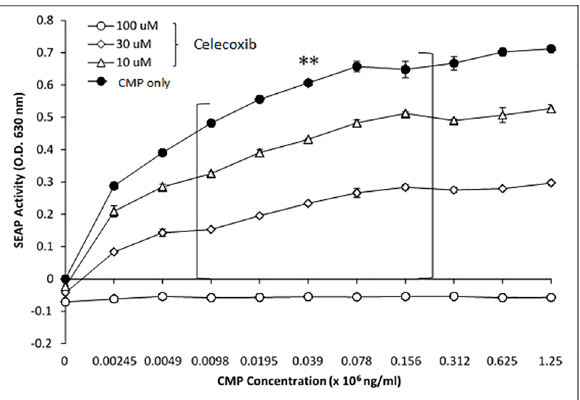
Fig 7. Celecoxib inhibits CMP activation of TLR4 in a dose-dependent manner. HEK-TLR4 cells were pre-treatedwith with 0 μ M (filled circles), 10 μ M (open triangles), 30 μ M (open diamonds), or 100 μ M (open circles) celecoxibfor one hour prior to treatment with increasing concentrations of CMP as indicated.SEAP activity was measuredthe next day to evaluate cellularactivation.CMP-induced SEAP activity was significantly reducedby celecoxibtreatment (open symbols). Significance between the collectiveregressions is represented by the asterisks p (cid:20) 0.005.